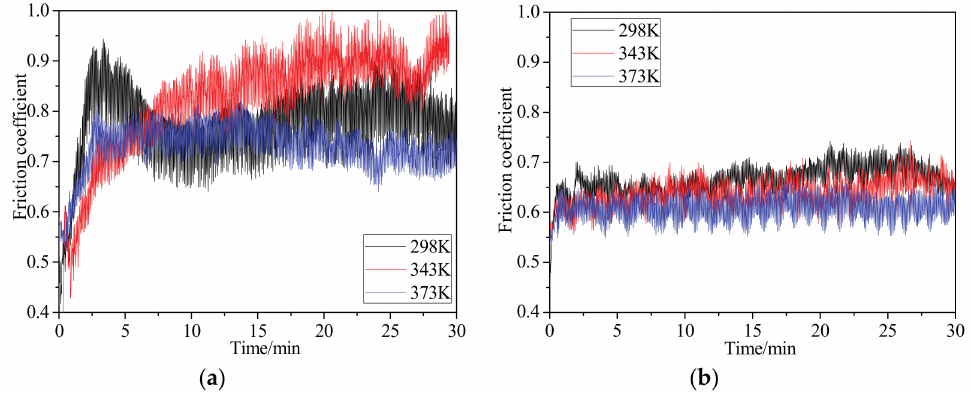
Figure 11. The friction coe ffi cient curves of untreated specimens and plasma-nitrided specimens under di ff erent friction temperatures: ( a ) untreated ( b )